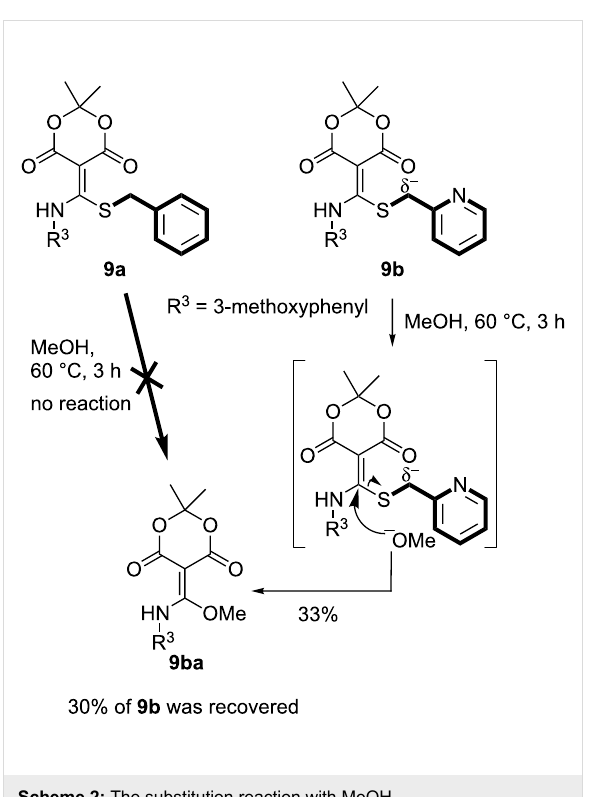
Scheme 2: The substitution reaction with